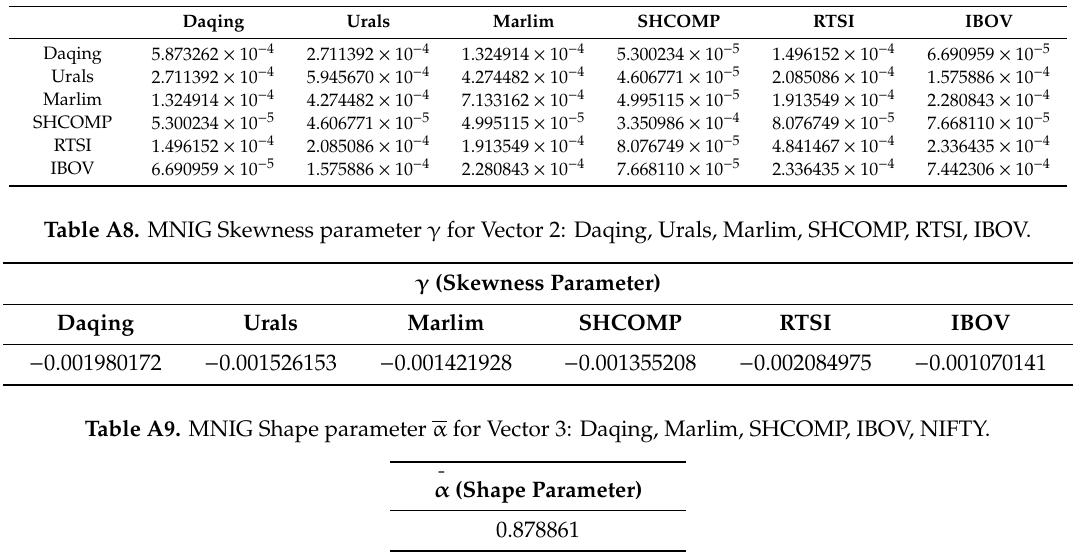
Table A10. MNIG Location parameter µ for Vector 3: Daqing, Marlim, SHCOMP, IBOV, NIFTY. µ (Location Parameter)